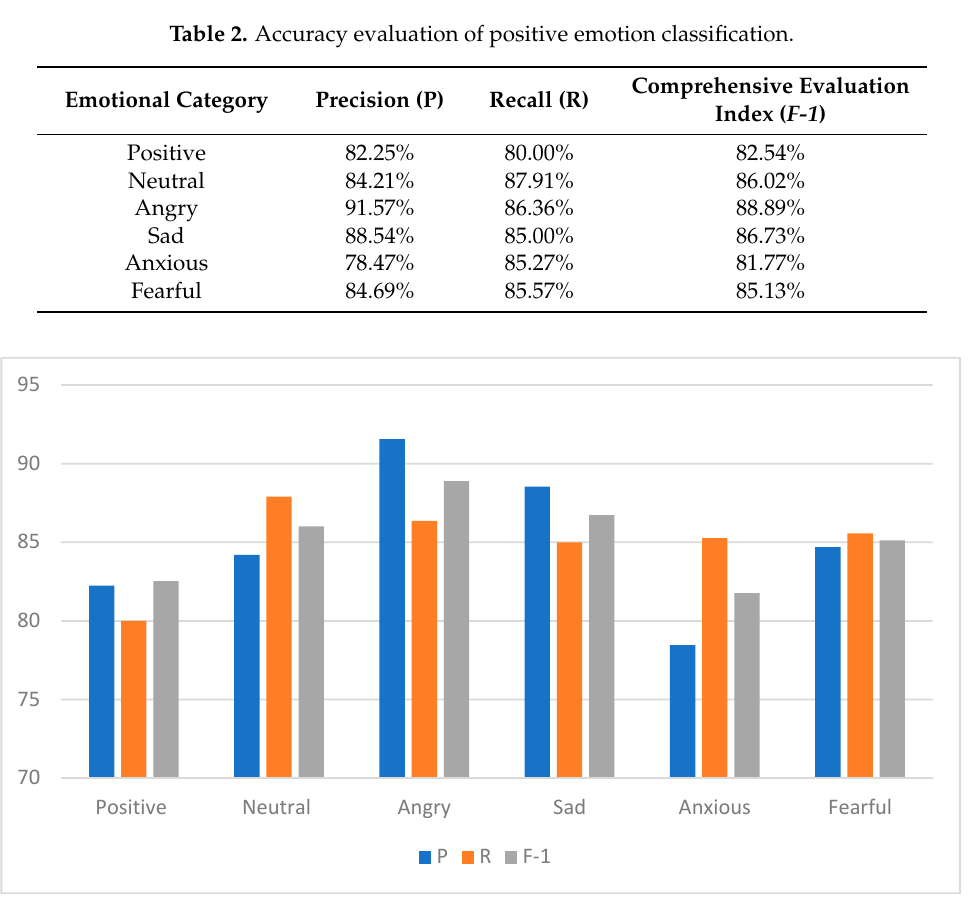
Table 3. Proportion of data with different accuracy in different cities.